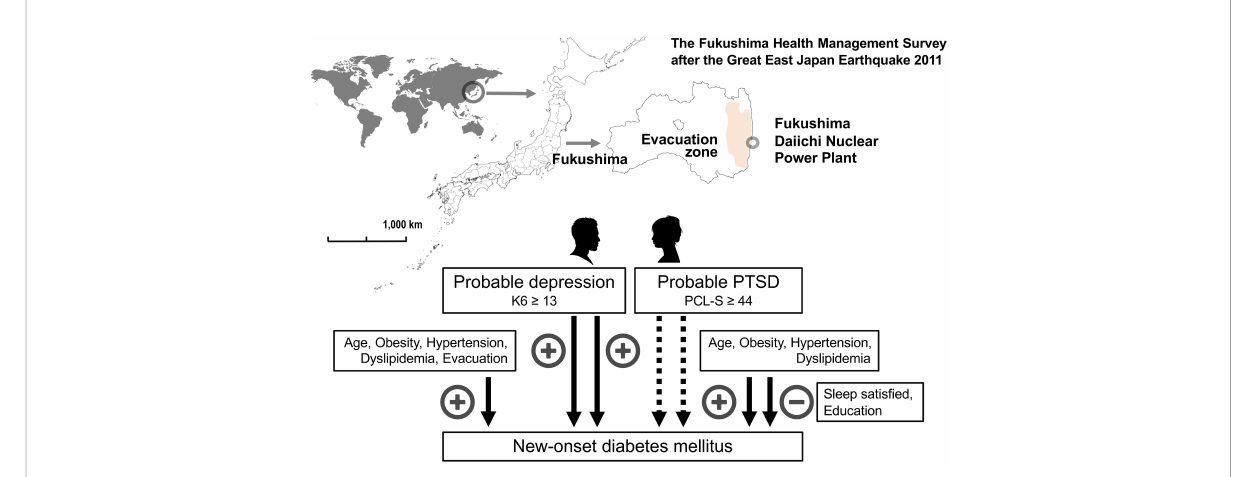
FIGURE 4 Graphic summary of the main fi ndings of the article. The Fukushima Health Management Surve study targeted 123,314 people aged 40 – 74 years and was of fi cially registered as being from 13 administrative districts at the time of the Great East Japan Earthquake 2011. Factors associated with new-onset diabetes mellitus in men and women were shown based on the Cox proportional hazards model after multivariate adjustment for established risk factors. Factors positively (+) and negatively ( – ) associated with new-onset diabetes mellitus were shown. Probable depression was de fi ned as a Kessler 6 scale (K6) ≥ 13 and probable post-traumatic stress disorder (PTSD) as a PTSD Checklist — Stressor-Speci fi c Version (PCL-S) ≥